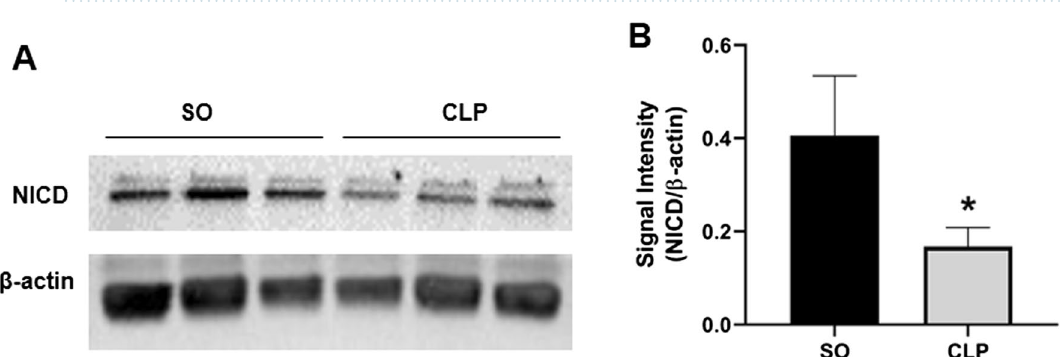
Figure 4. Sepsis down-regulated Notch intracellular domain (NICD) level in mouse aorta. Representative Western blot images ( A ) and bar diagram ( B ) showing the effect of sepsis on the protein level of NICD in mouse aorta (n = 5). Vertical bars represent SEM. ‘n’ represents number of independent samples from different groups. Data were analyzed by unpaired student’s ‘t’ test. * p < 0.05 vs. SO. The NICD and β-actin bands were cropped from full blot (Supplementary Fig. S1